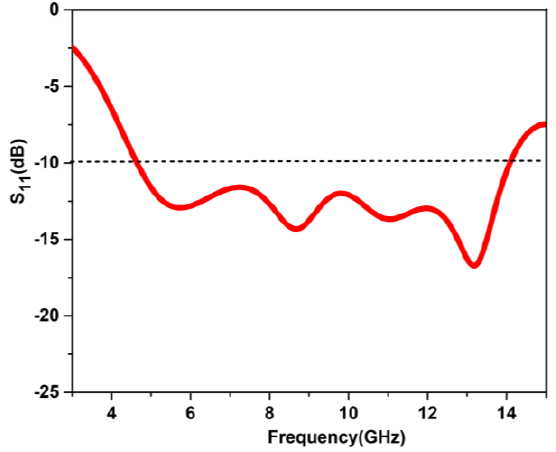
Figure 2. S 11 features of the designed UWB antenna.